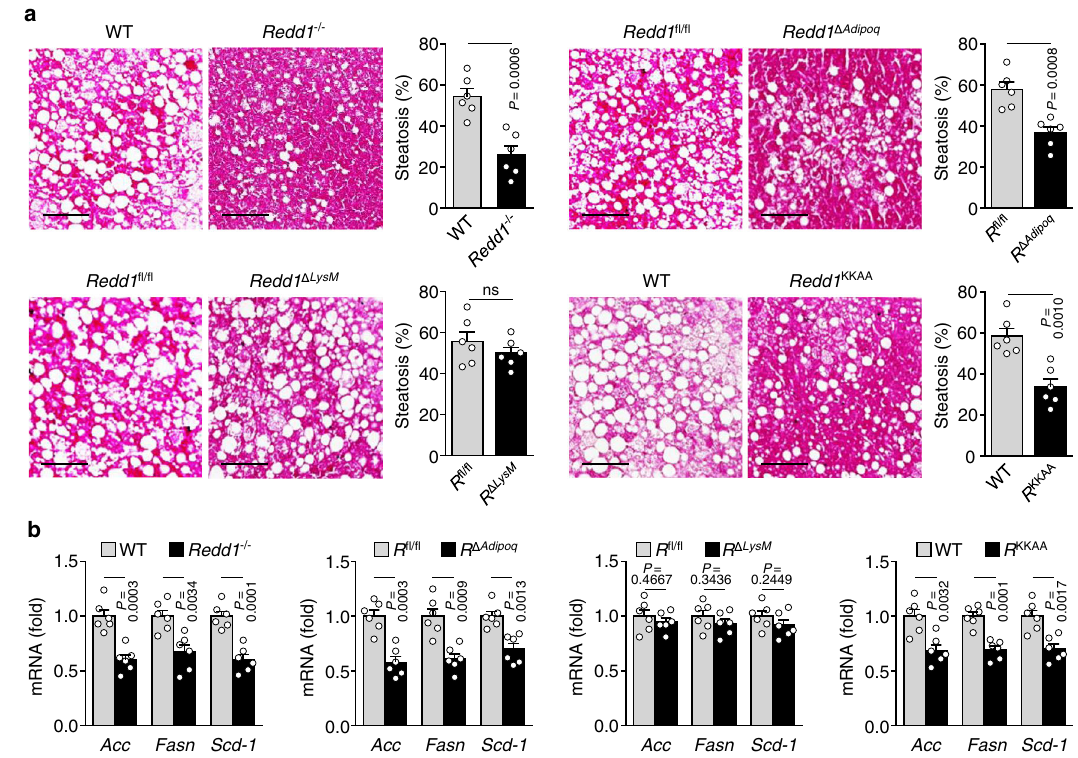
Fig.8|Globaloradipocyte-speci fi clossof Redd1 preventsHFD-inducedhepatic steatosis. a Representative images of H&E-stained liver tissues from HFD-fed Redd1 − / − , Redd1 Δ Adipoq , Redd1 Δ LysM , Redd1 KKAA , and control mice, and quanti fi cation of hepatic steatosis from H&E-stained liver tissues ( n =6 per group). Scale bars,